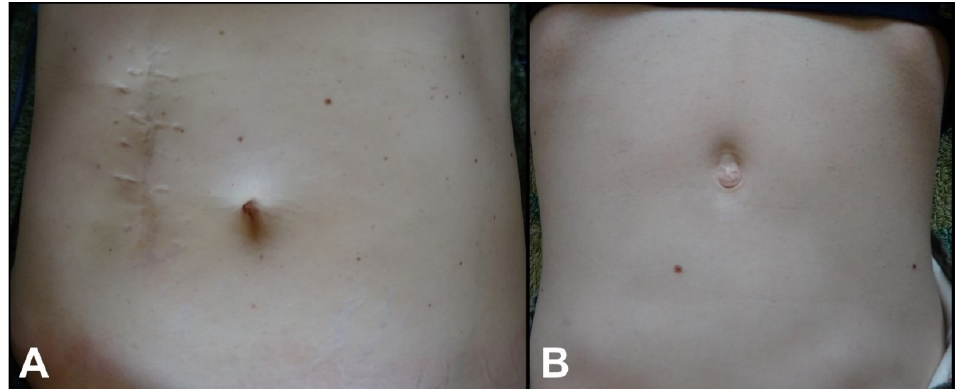
Figure 3. ( A , B ): ( A ) Cosmetic appearance of the abdomen of the mother at the age of 45 years after laparotomy for congenital hypertrophic pyloric stenosis (CHPS) on day 5 of life. ( B ) Cosmetic appearance of the abdomen of her daughter at the age of 13 years after laparoscopic pyloromyotomy for CHPS on day 7 of life. Both had an uneventful postoperative period and are healthy at the time of this report.